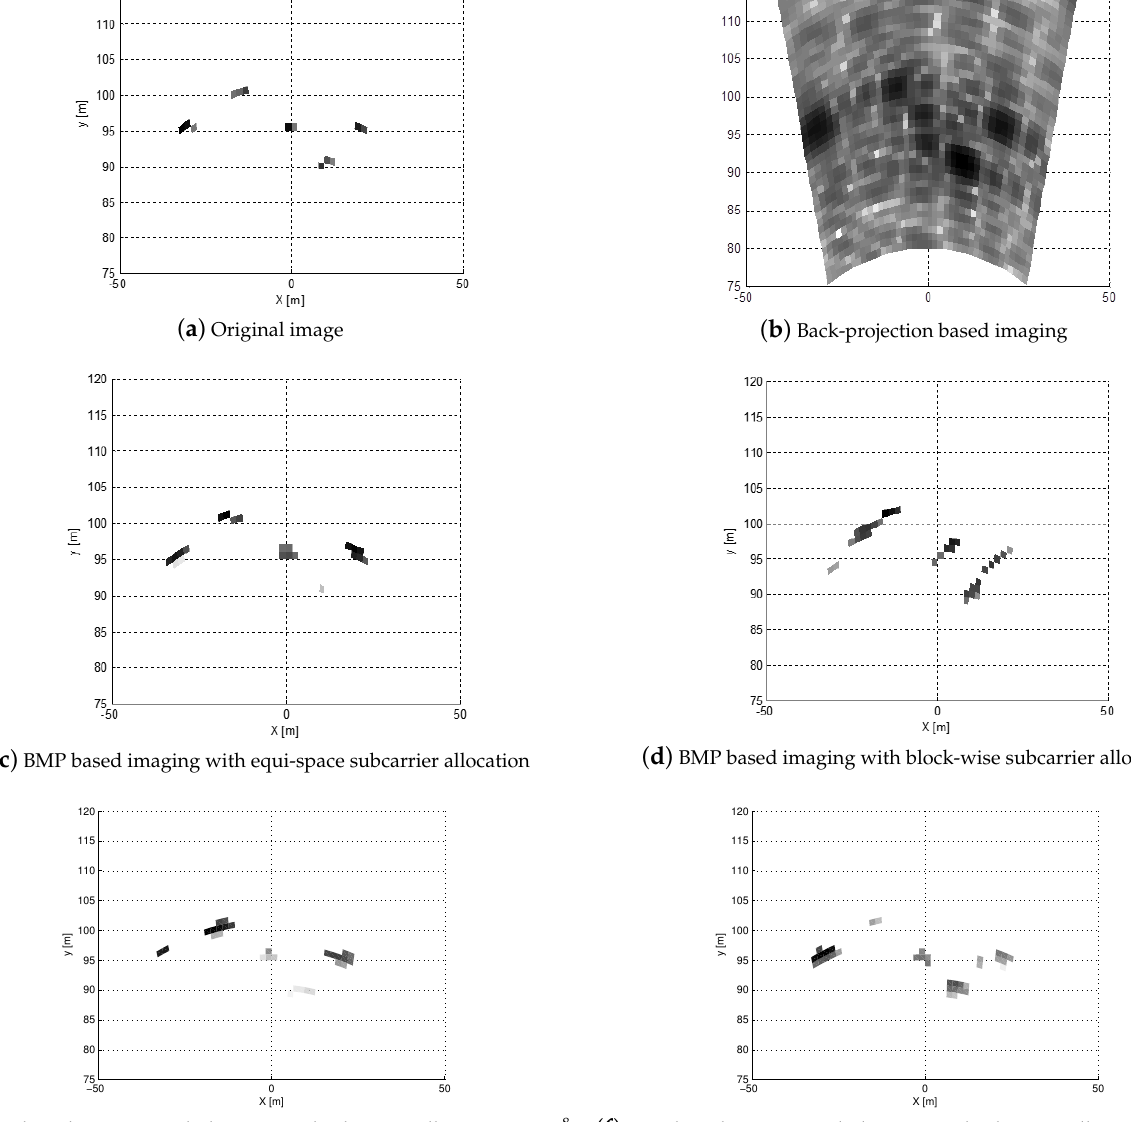
Figure 5. Radar images when MIMO OFDM radar is exploited with M t = 4 and M r = 4 at SNR rec = 14